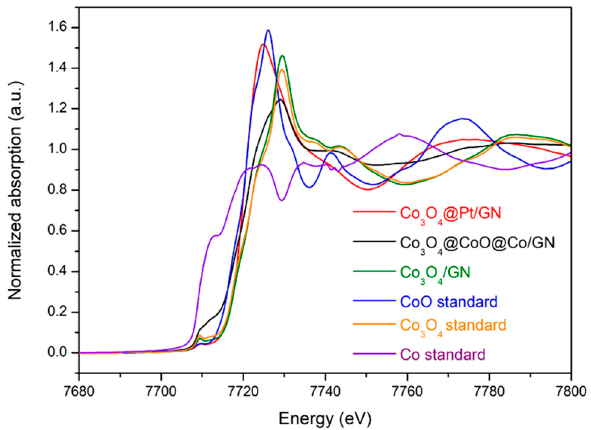
Figure 3. The Co K-edge X-ray absorption near-edge spectra (XANES) profiles for Co 3 O 4 / GN, Co 3 O 4 @CoO@Co / GN, and Co 3 O 4 @Pt / GN, as well as standard materials of Co, CoO, and Co 3 O 4 .